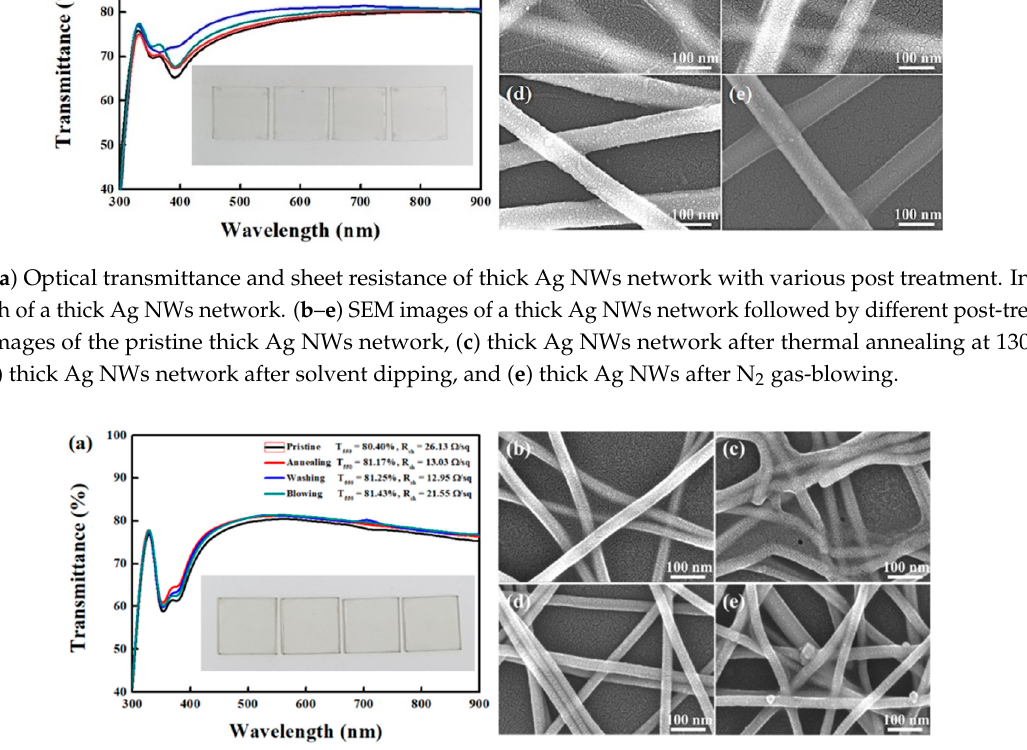
Figure 3. ( a ) Optical transmittance and sheet resistance of a thin Ag NWs network with various post treatment. Inset is a photograph of the thin Ag NWs network. ( b – e ) SEM images of the thin Ag NWs network followed by different post-treatment. ( b ) SEM images of the pristine thin Ag NWs network, ( c ) thin Ag NWs network after thermal annealing at 130 °C for 20 min, ( d ) thin Ag NWs network after solvent dipping, and ( e ) thin Ag NWs after N 2 gas-blowing.